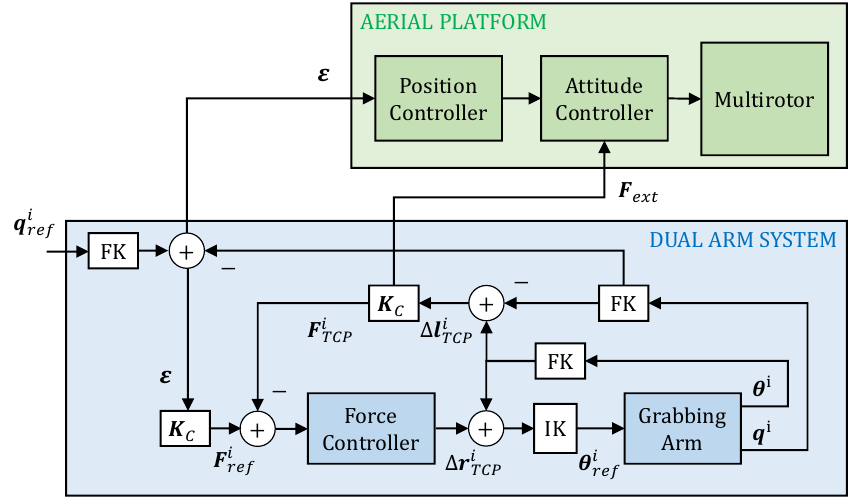
Figure 7 . Control scheme of the aerial manipulator with grabbing arm ( 𝑖 = 2 ). Figure 7. Control scheme of the aerial manipulator with grabbing arm ( i =